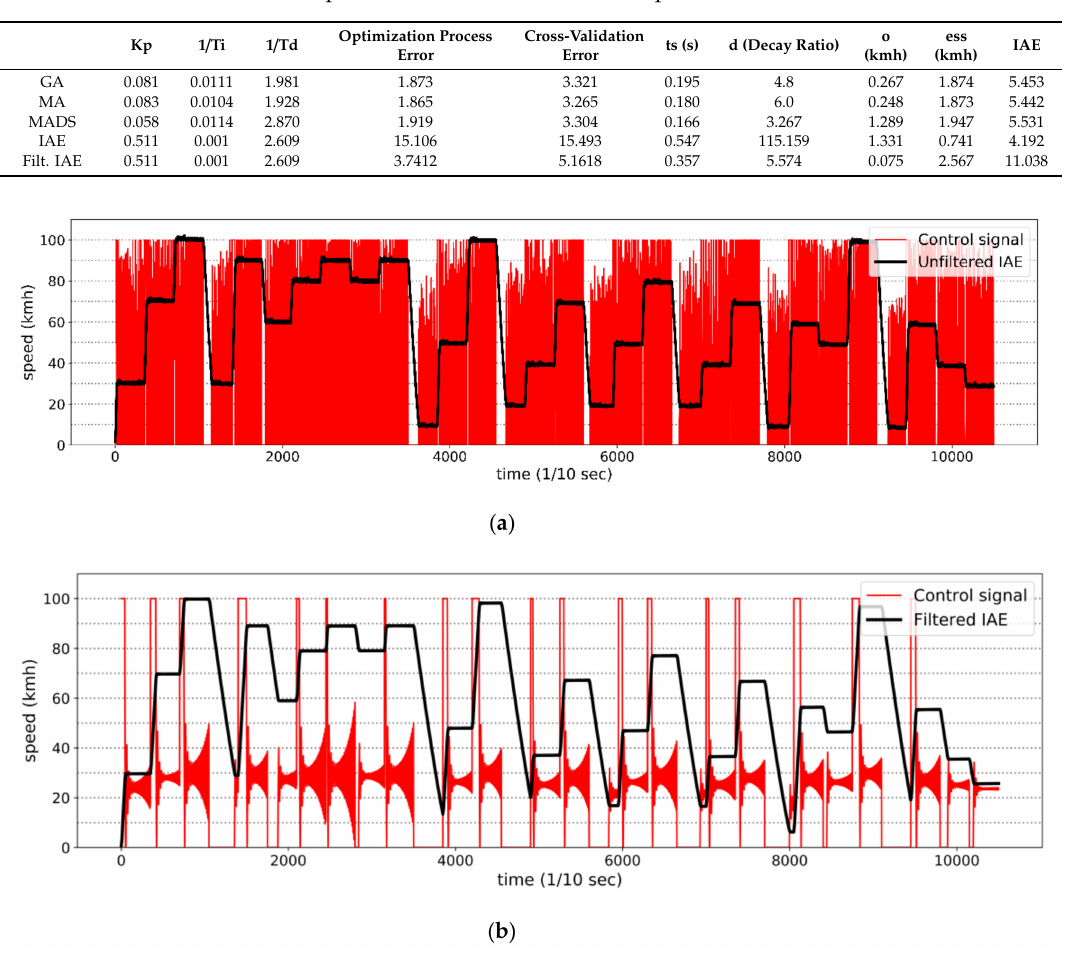
Figure 3. Representation of the performance of IAE optimized controller, with the system output unfiltered ( a ) and filtered ( b